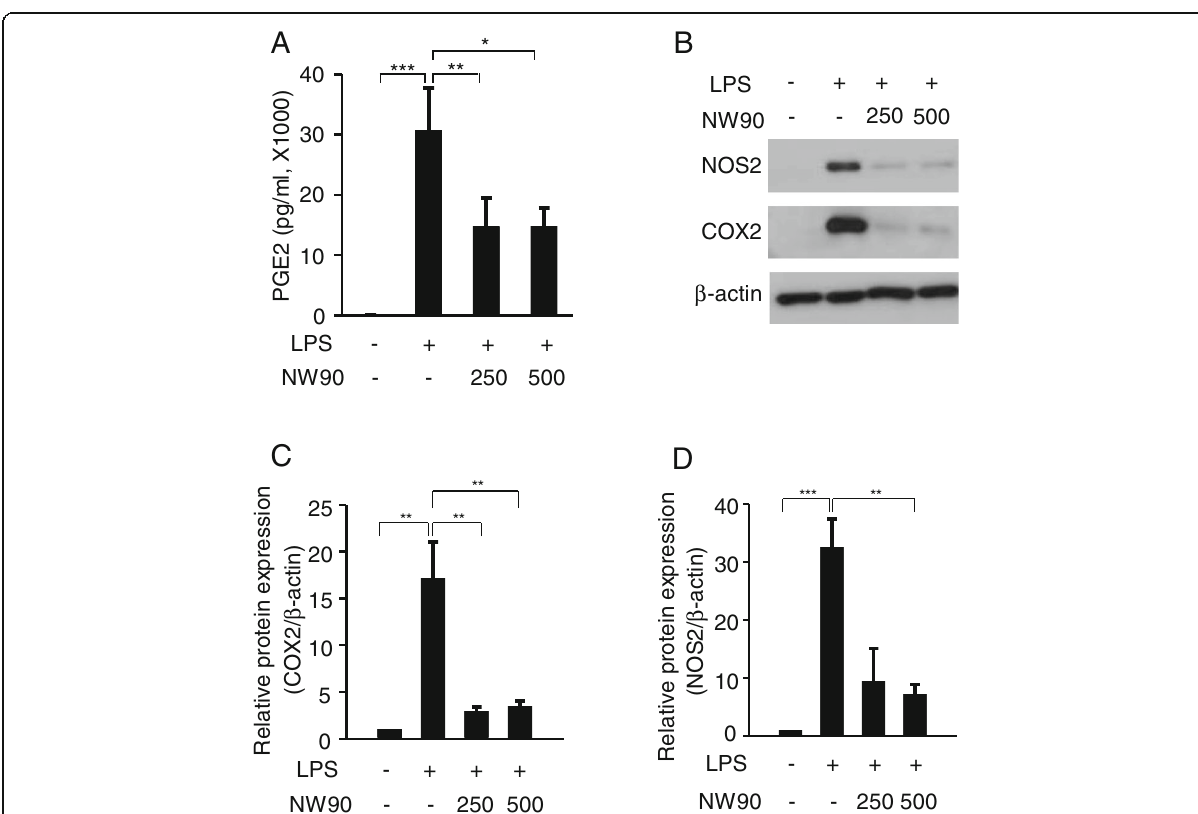
Fig. 2 Effects of Papaver nudicaule extract NW90 on the expression of PGE2, COX2, and NOS2. RAW264.7 cells were treated with NW90 extract (250 and 500 μ g/ml) and LPS (100 ng/ml) for 24 h. a The PGE2 production was measured in the culture supernatants. b Cells were lysed and the expression of COX2 and NOS2 was examined by western blotting. β -actin was used as an internal control. c , d Quantification of COX2 and NOS2 expression with normalization to the β -actin protein levels were analyzed by densitometry analysis of every band using the ImageJ software. Data are presented as mean ± SD from at least three independent experiments. * P < 0.05, ** P < 0.01 and *** P < 0.001 indicate statistically significant differences compared with the group treated with LPS